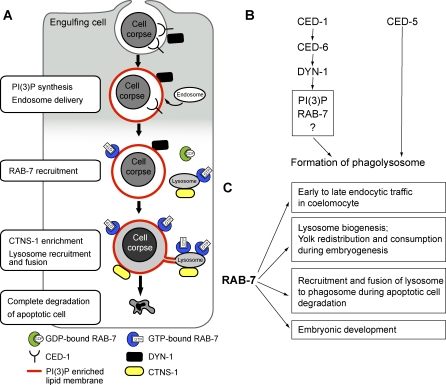
Signaling Pathways That Control the Degradation of Apoptotic Cells(A) Diagram summarizing the sequential molecular events that occur during the maturation of phagosomes containing apoptotic cells in C. elegans.(B) Diagram of the signaling pathways that promote the formation of phagolysosome.(C) A summary of the functions of C. elegans RAB-7.